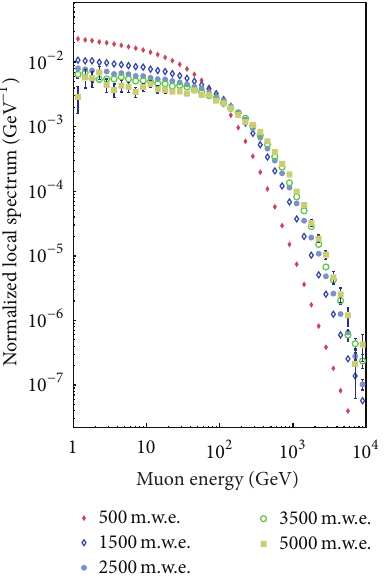
Figure 2: Normalized differential muon intensities in selected depths of standard rock (color online).